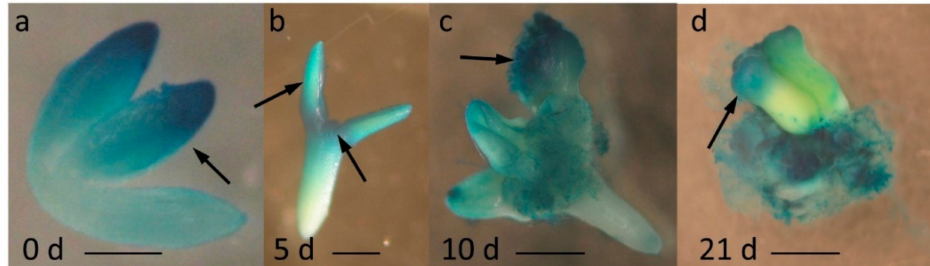
Figure 1. The spatiotemporal expression pattern of MIR396b in immature zygotic embryo (IZE) explants that were cultured for ( a ) 0, ( b ) 5, ( c ) 10, and ( d ) 21 days on a standard somatic embryogenesis (SE) induction medium (E5). Cotyledons and the shoot apical meristem (SAM) area of the IZE,